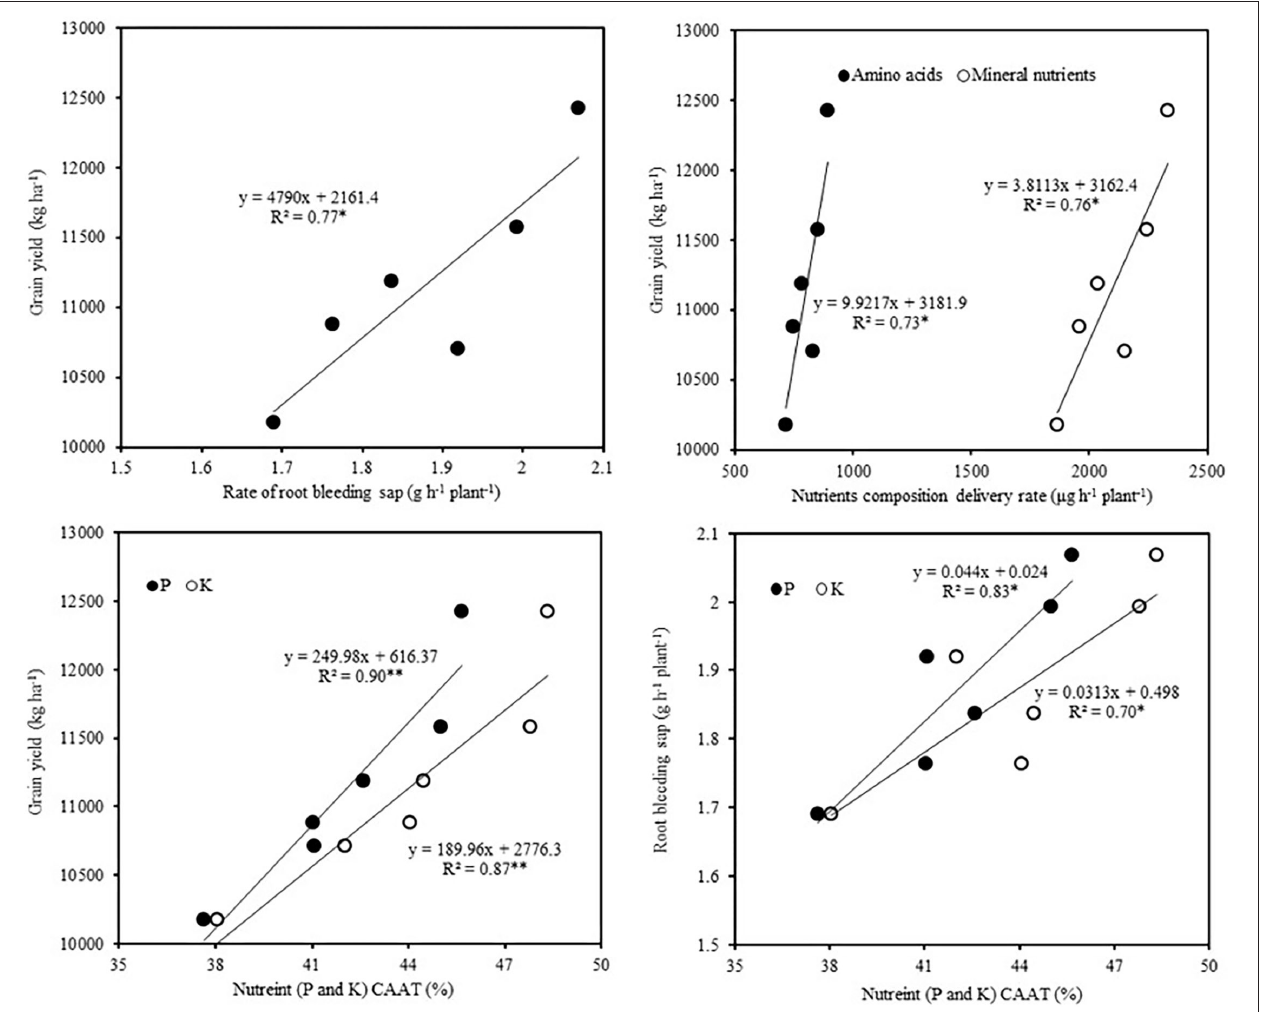
FIGURE 5 | Correlation analysis of root-bleeding sap, nutrient contribution, and grain yield (values are the average in both years). CAAT, contribution rate of nutrient (P or K) accumulation amount